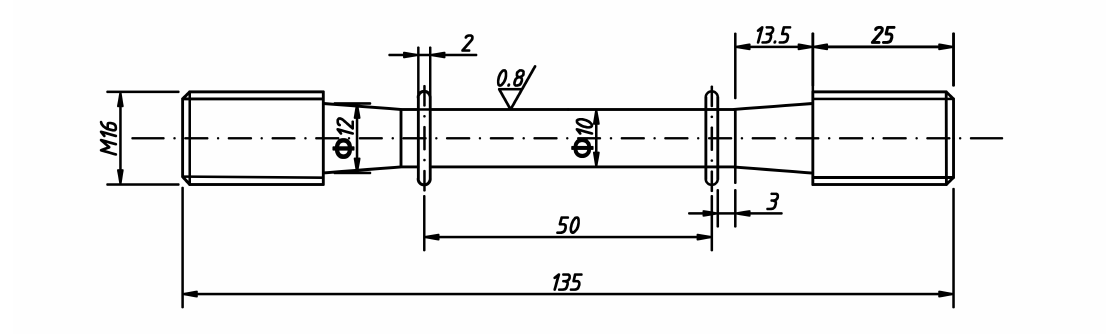
Figure 1. The dimension specification of test specimen (in mm).